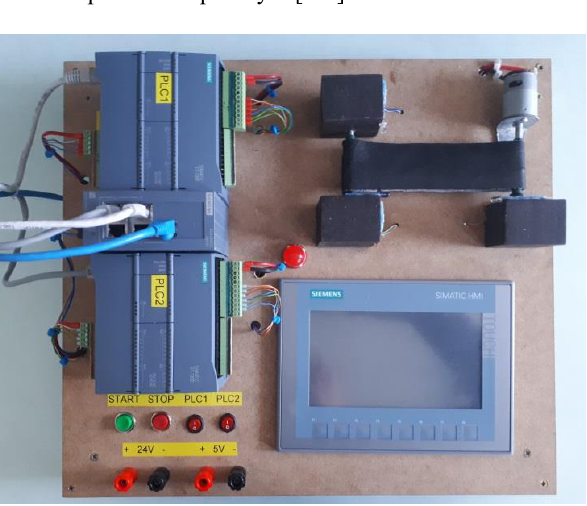
Fig. 1. The model of a distributed control system of a production line